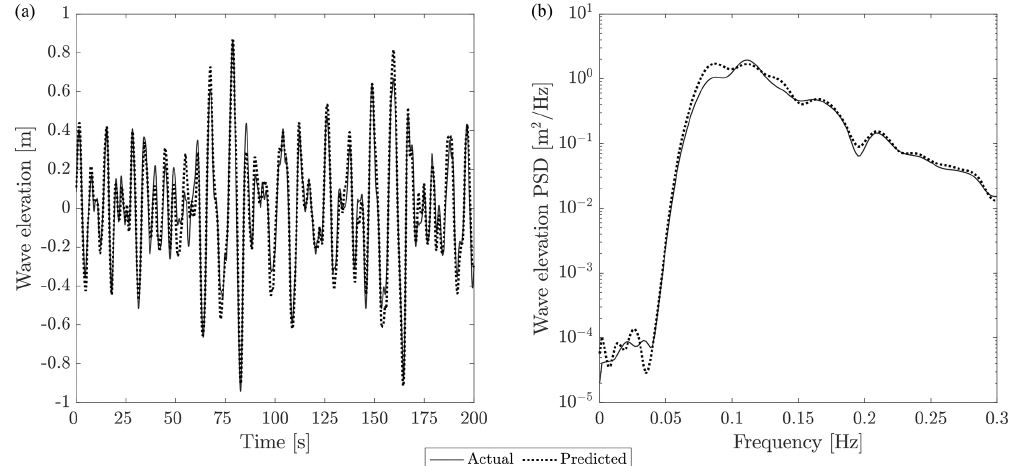
Figure 11. (a) The wave preview obtained by means of the prediction algorithm is compared with the wave at the platform location (in the plot, the preview is delayed by the preview time t d = 7 . 5s to ease the comparison). (b) The wave preview and measurement are compared based on their PSD.